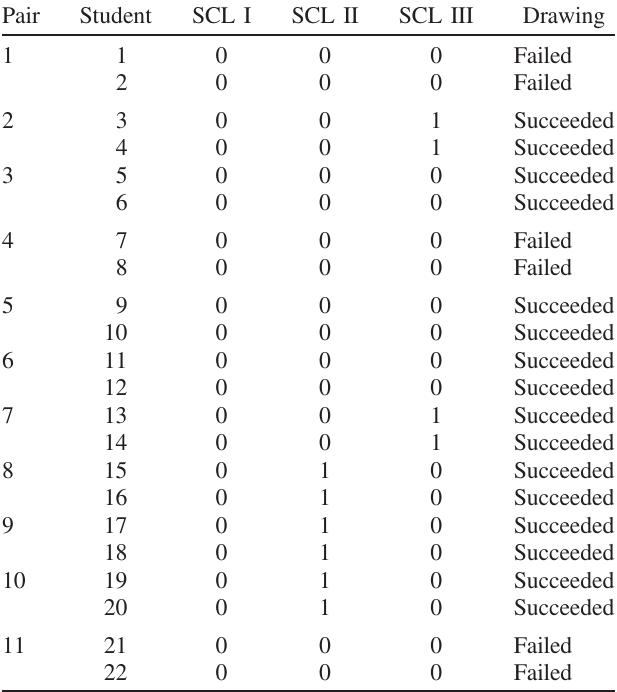
TABLE II. Students ’ results in the scaffolding (SCL) environ- ment for question (a) ( “ 1 ” indicates that students answer the question correctly, “ 0 ” indicates that students answer the question incorrectly).